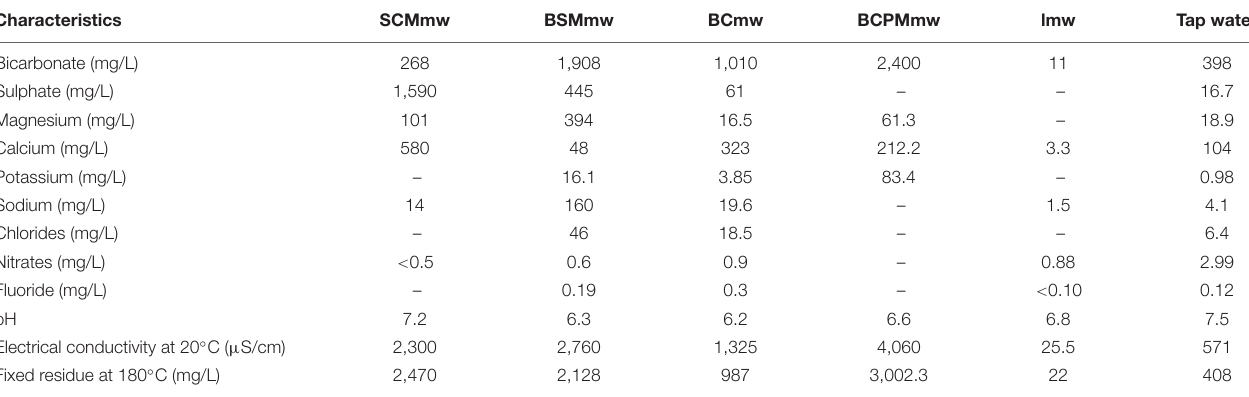
Trends in body weight and blood biochemistry are presented in Figure 2 . An overall marked increase in all parameters, with the exception of triglycerides, was observed in mice on HCD. This increase was more substantial in males than in females. Changes in body weight and blood biochemistry among healthy untreated mice on StD over the entire 6-month period are shown in Supplementary Table 1 . Trends in body weight and blood biochemistry of combined males and females are shown in Supplementary Figure 1 . Changes in Body Weight Both male and female mice gained weight on the HCD, though males did so more rapidly than females over the 4-month period. At T4, the average weight gain of males was 21.64 g and that of females was 12.98 g. Significant differences in both absolute ( (cid:49) BW) and relative ( C BW) body weight gains were found between males and females ( P < 0.0001) ( Table 2 ).